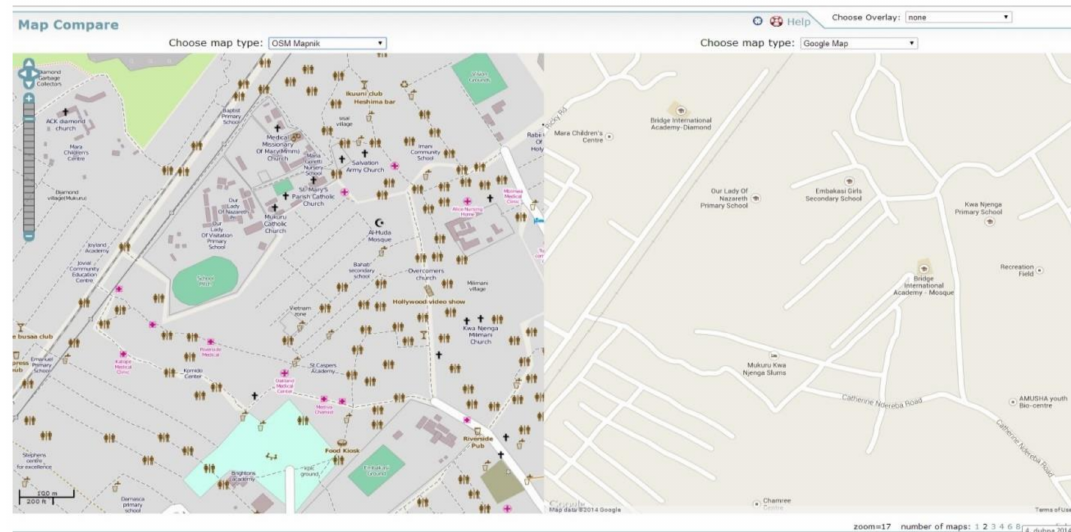
Figure 4. Part of the Mukuru area on OpenStreetMap and Google Maps at scale